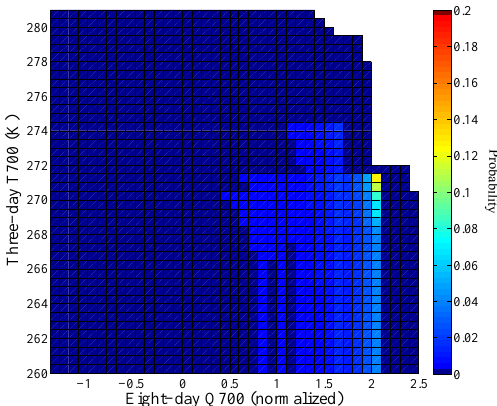
Figure 7. Probability of a local convection flash event based on atmospheric indicators CAPE and normalized specific humidity at 700hPa (between 1989 and 2003).